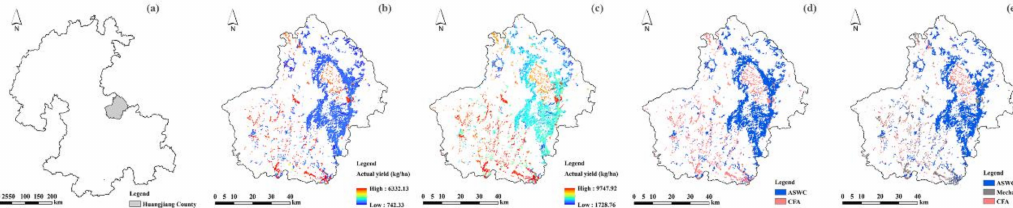
Figure 9. ( a ) Location of Huanjiang County; ( b ) The mixed actual grain crop yield of Huangjiang in 2000; ( c ) The mixed actual grain crop yield of Huangjiang in 2015; ( d ) Dominant key factors distribution of Huangjiang in 2000; and, ( e ) Dominant key factors distribution of Huangjiang in 2015 (AWC: Available soil water capacity; Mechan: Mechanization; CFA: Chemical fertilizer